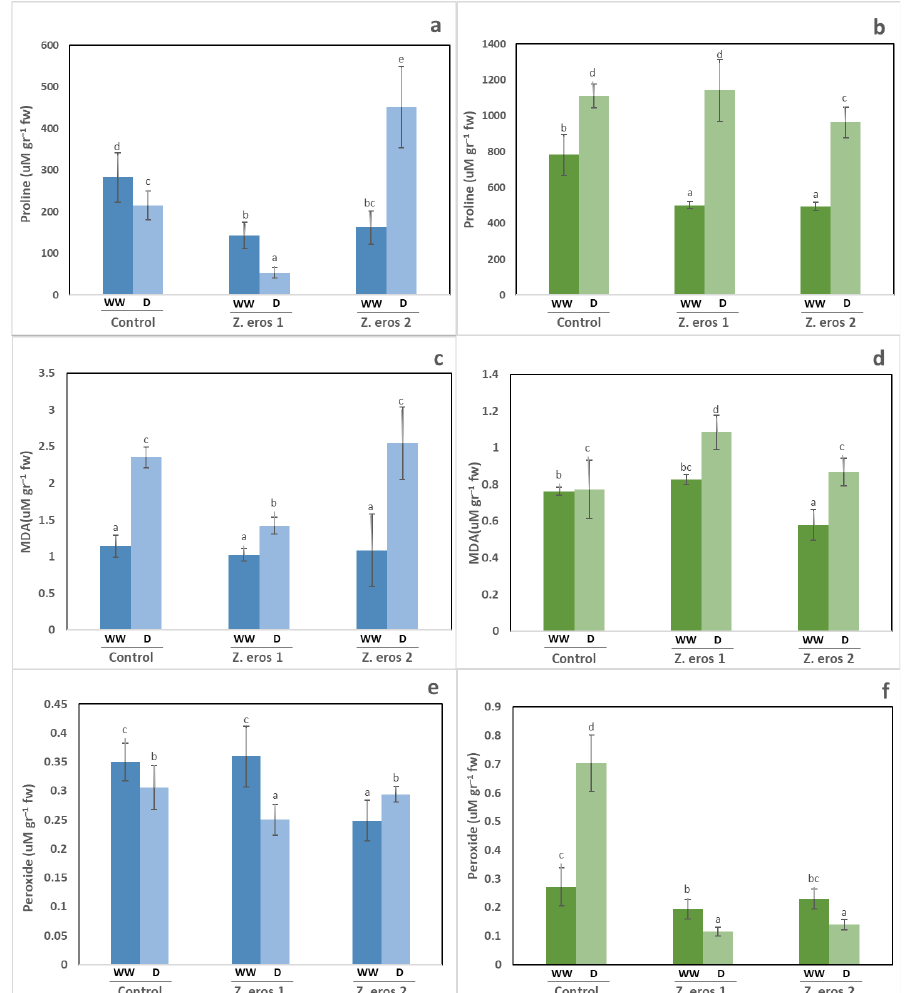
Figure 5. Proline content ( a , b ), MDA ( c , d ) and hydrogen peroxide content ( e , f) in wheat and tomato plants respectively. Plants were inoculated with the fungal endophytes Z. erostrata 1 y Z. erostrata 2 and cultivated under well-watered (WW) or drought (D) conditions. Values are the means ± standard deviation of four replications. According to Duncan’s multiple-range test ( p < 0.05), different letters indicate significant differences between all treatments.